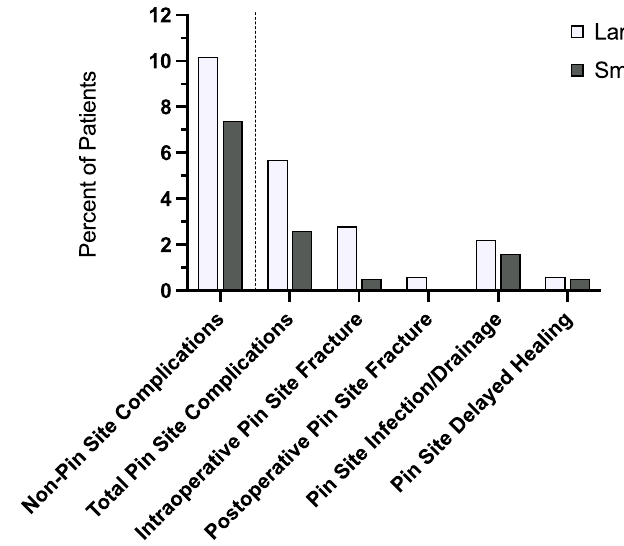
Fig. 2 Complications by pin diameter group (RA-TKA